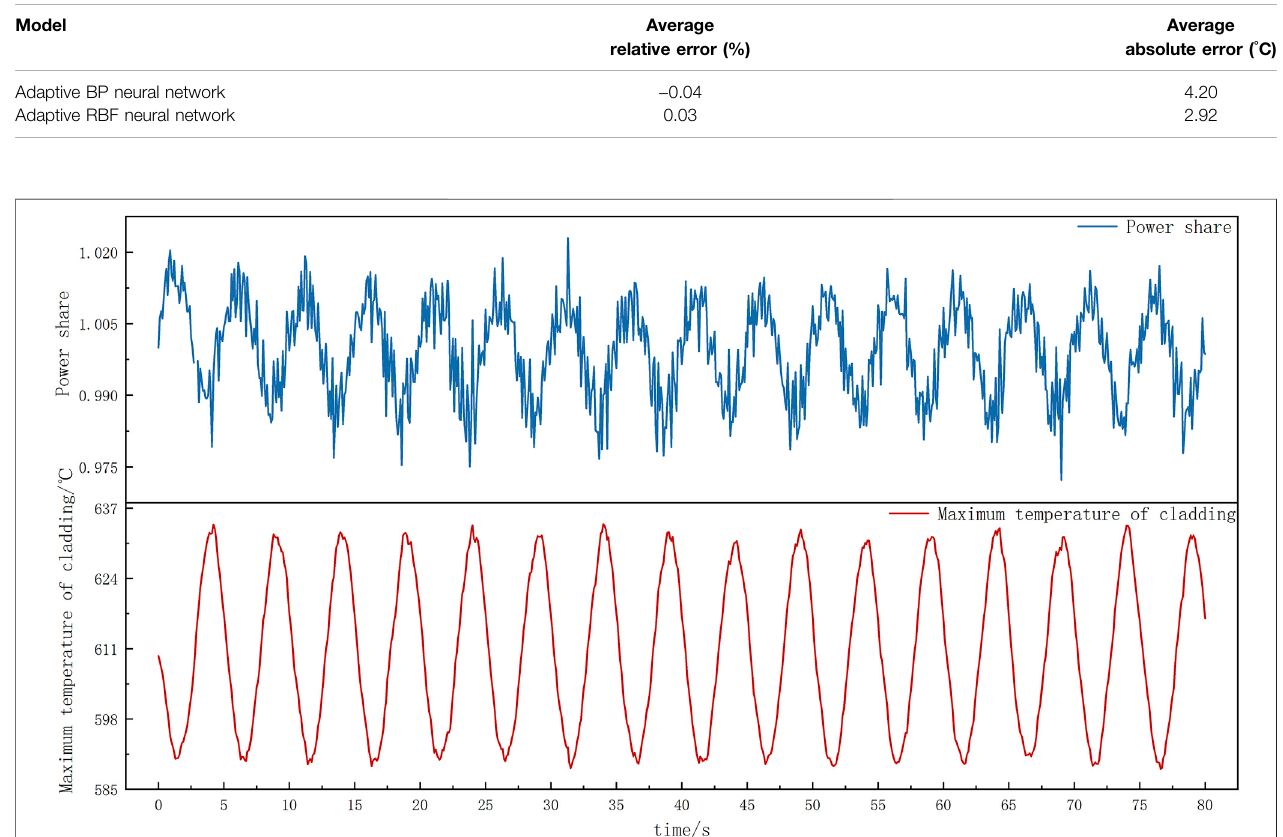
Figure 11 gives the predicting error bound of the adaptive BP neural network and adaptive RBF neural network during power variation condition separately. The average error data